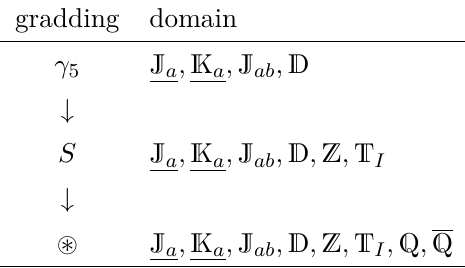
Table 1 . Underlined are the odd generators w.r.t. each gradding operator. The spin 1/2 represen- tation of the conformal algebra ( su (2 , 2) ) has a natural gradding defined by γ allows us to construct the grading S of su (2 , 2) × su ( N ) . With S we can define the gradded dual operator ~ that acts on su (2 , 2 | N ) , that introduces the grading